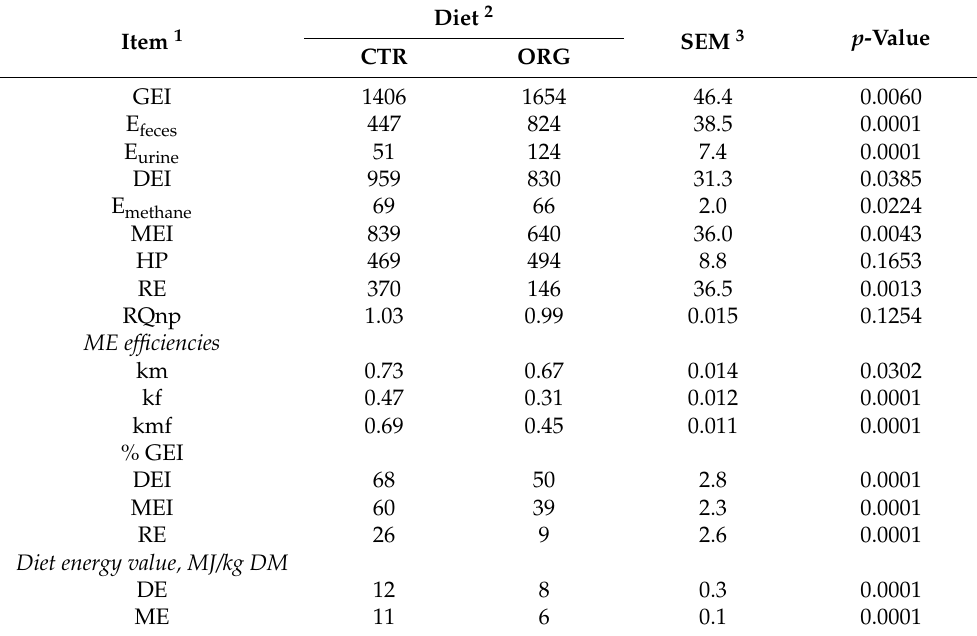
Table 5. Energy balance (kJ/kg of BW 0.75 and day) of Murciano-Granadina dried goats ( n = 10) by the type of